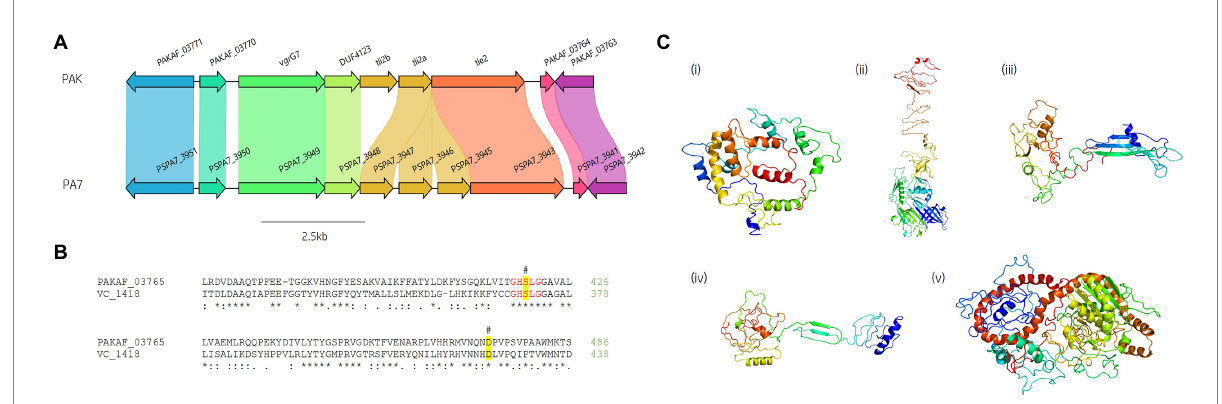
FIGURE 9 In silico analysis of the vgrG7 island shows that it contains a putative lipase effector. (A) Comparative visualisation of the vgrG7 island in reference P. aeruginosa strains PAK and PA7 (CP000744.1). (B) Partial amino acid sequence alignment of PAKAF_03765 (Tle2 PAK ) from PAK to Tle2 VC (TseL/ VC_1418, AAF94575.1) from Vibrio cholerae O1 biovar El Tor str. N16961. The catalytic residues are indicated by a # and highlighted yellow. The GxSxG motif is highlighted in red. An asterisk (*) indicates fully conserved residues, a colon (:) indicates a strongly similar property at the residue, and a period (.) indicates a weakly similar property at the residue. The alignment was created using ClustalOmega (EMBL-EBI; Madeira et al., 2022). (C) Phyre2 predicted models of (i) DUF4123-containing protein (PAKAF_03768), (ii) VgrG7 (PAKAF_03769), (iii) Tli2 b (PAKAF_03767), (iv) Tli2 a (PAKAF_03766), and (v) Tle2